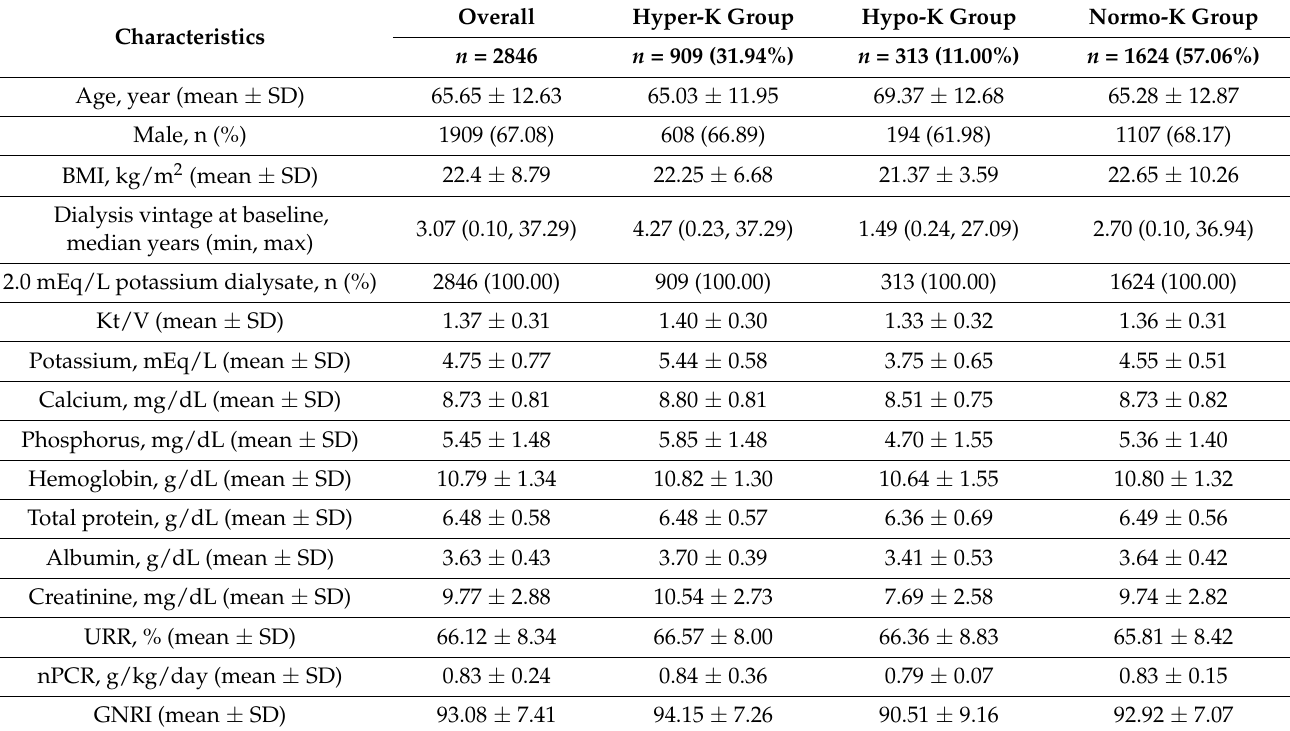
Table 1. Baseline outpatient